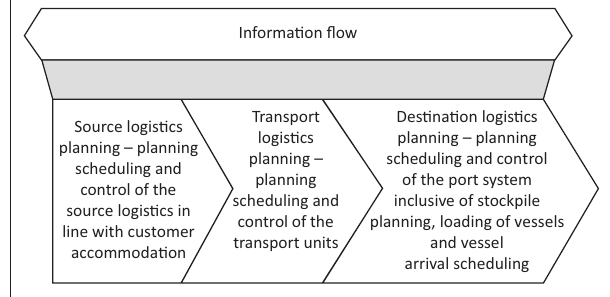
FIGURE 4: Information flow in the bulk coal export supply